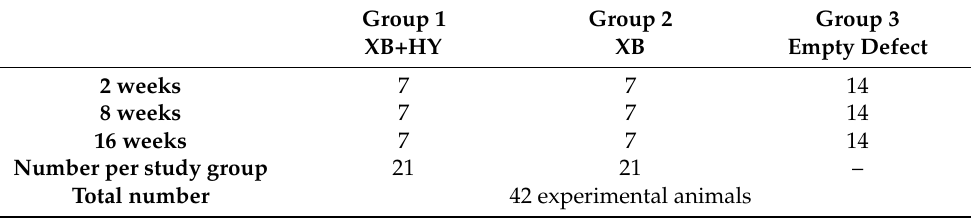
Table 9. Overview of the study groups displaying the experimental animals per group and time